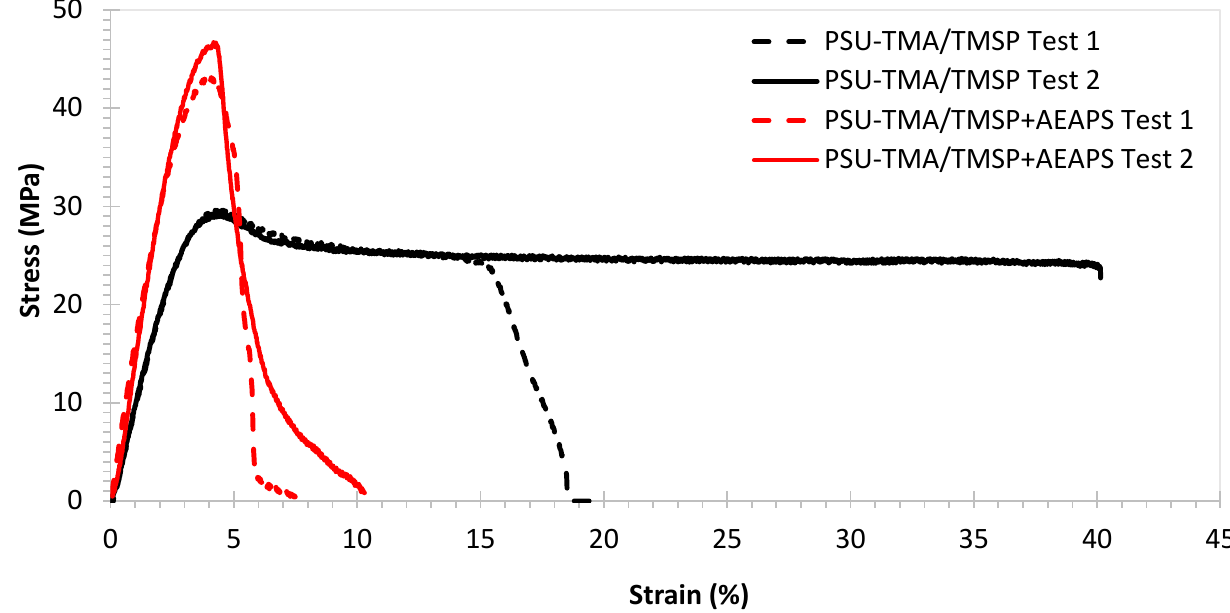
Figure 3. Tensile stress–strain curves for membranes in Cl − form at(40 ± 2)% relative humidity and temperature ((25 ± 1) °C).